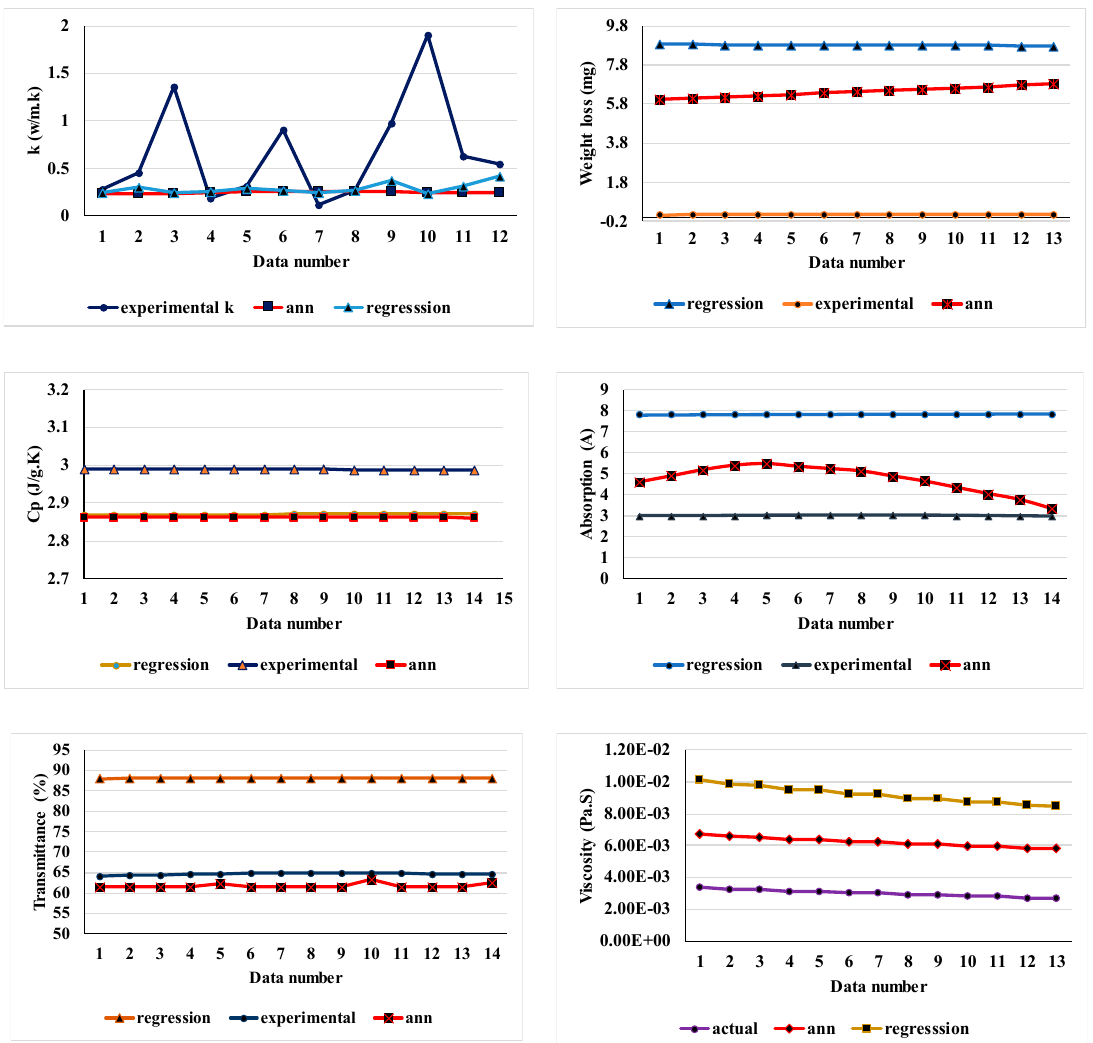
Figure 11. Thermo physical properties comparison plot of ANN vs. Regression vs. experimental.